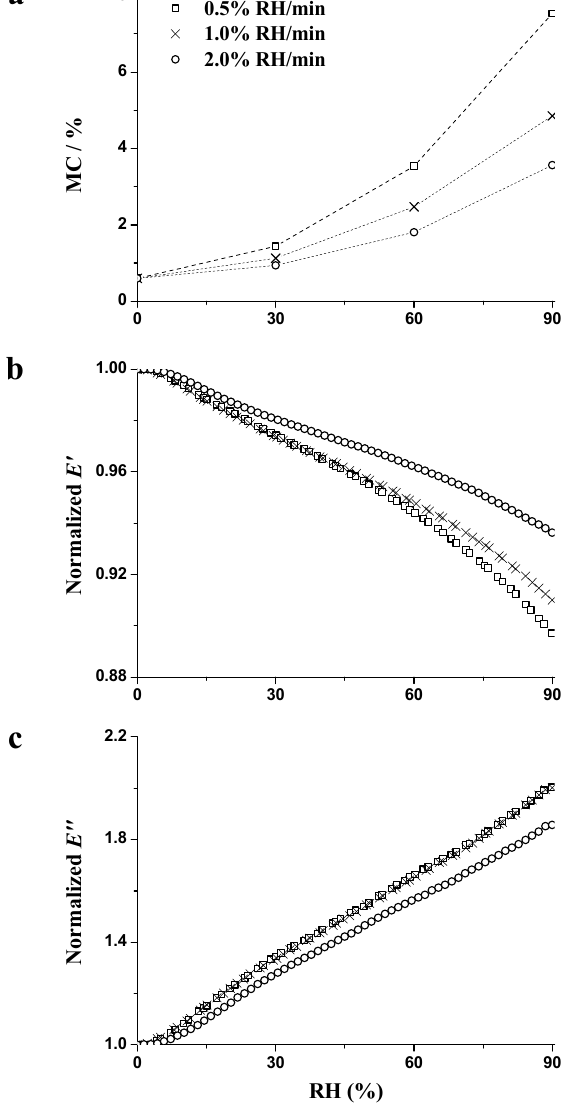
Figure 5. Influence of RH on the MC ( a ); normalized E ′ ( b ); and normalized E ″ ( c ) during the RH ramp period (0% → 90% RH) with different RH ramping rates.